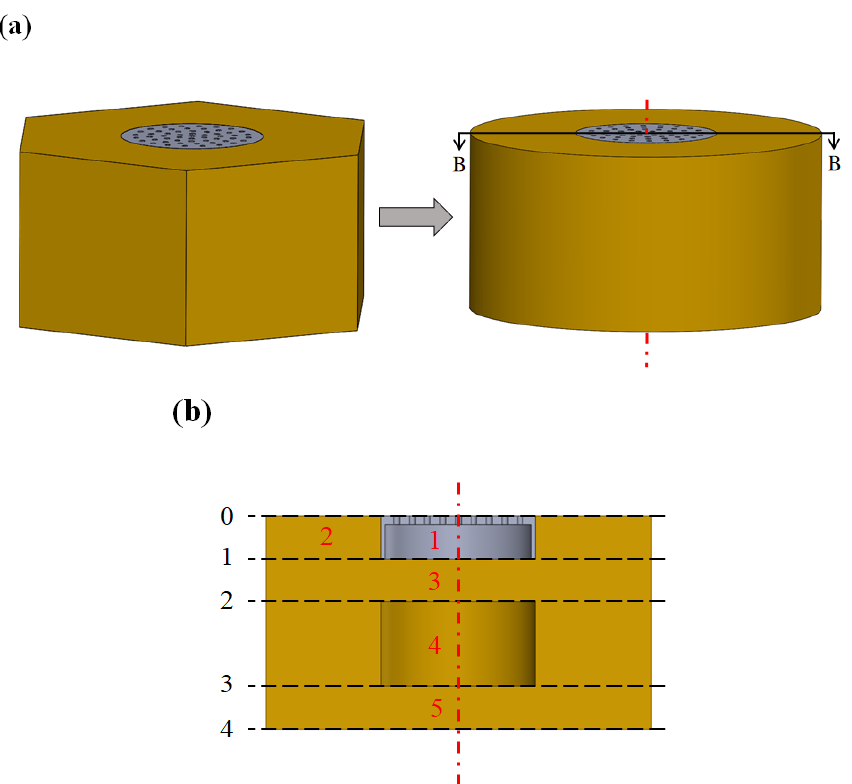
Figure 2. ( a ) Schematic of approximate model of developed hybrid sound-absorbing metastructure and ( b ) two-dimensional plot of cut plane B–B of multiple sections of hybrid sound-absorbing struc- ture.